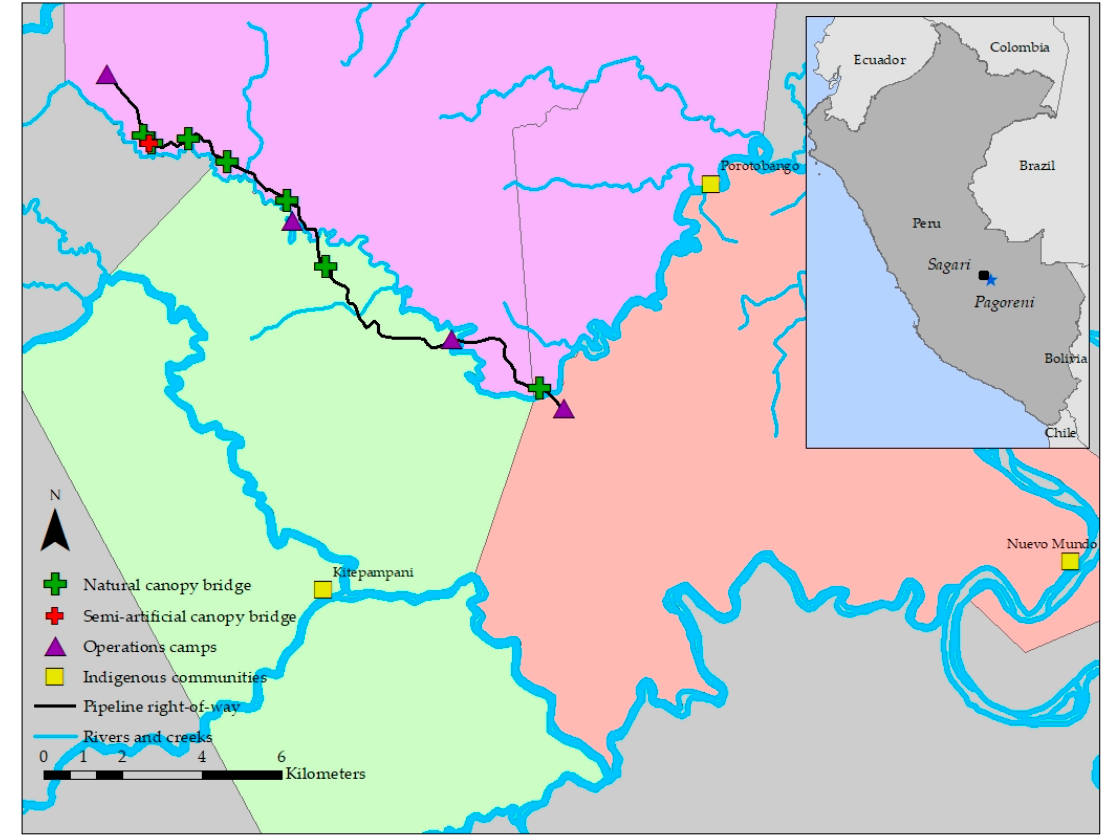
Figure 1. Map of the study area at Sagari, including the 18.5 km piece of pipeline right-of-way (RoW) (black line). The locations of both the natural canopy bridges (NCBs) (green crosses) and the semi-artificial canopy bridge (SACB) (red cross) are indicated, as are the locations of the operations camps (purple triangles) and nearest indigenous communities (yellow squares) and their respective territories (polygons). In the inset, the locations of Sagari (black square) and Pagoreni (blue star ~25 km to the southeast), another canopy bridge research location mentioned in the Discussion is labeled.